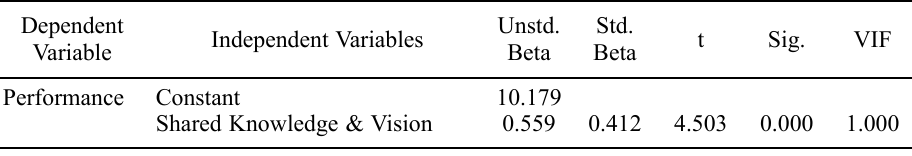
Table 3. Regression analysis – the influence of customer focus (market orientation), shared knowledge & vision (learning orientation) and Internet marketing orientation on performance Dependent Independent Variable